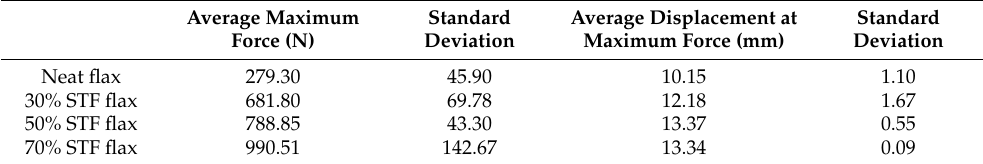
Table 1. Summarized Results of Flax and STF Impregnated Flax Fabric Puncture